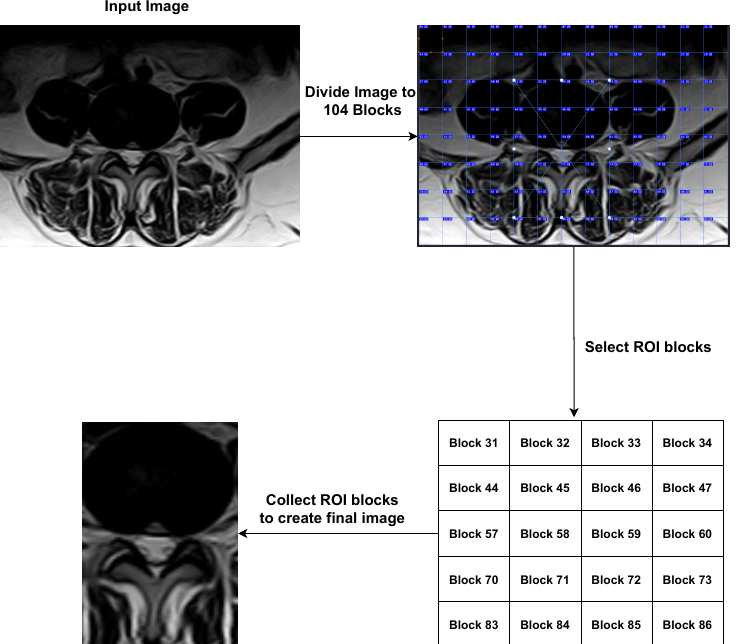
Figure 7. Steps to create ROI